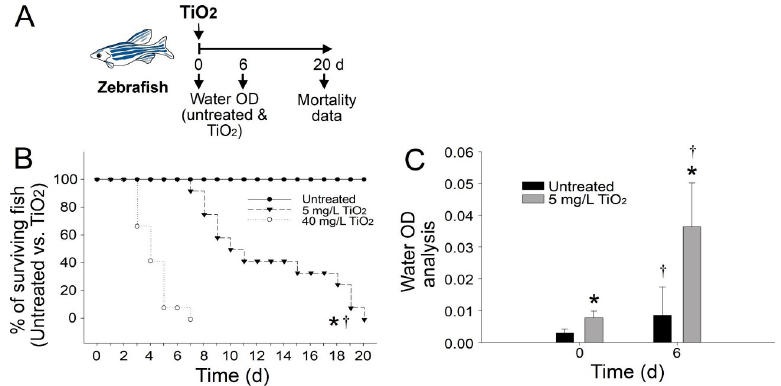
Fig 1. Zebrafish mortality is associated with increased TiO 2 NP levels in the water. (A) Experiment outline. (B) TiO 2 NP dose–dependent induction of mortality in zebrafish. (C) Increase in water OD after the addition of TiO 2 NPs. � P < 0.05, compared with the untreated group; † P < 0.05, compared with the 40 mg/L treatment groups (B);